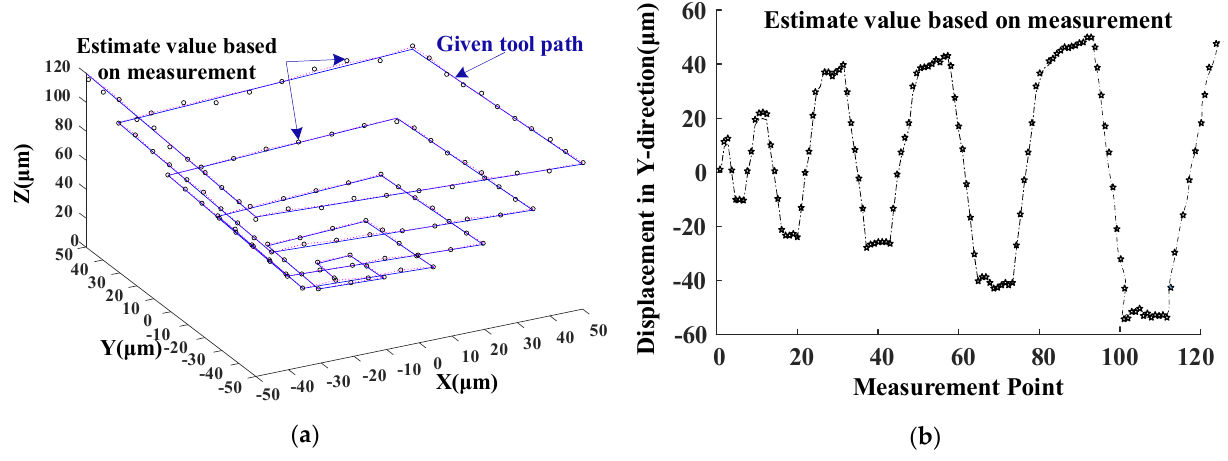
Figure 9. Estimate results of tool’s three-dimensional motion in space. ( a ) Tool motion in space. ( b ) Tool motion in y-direction.